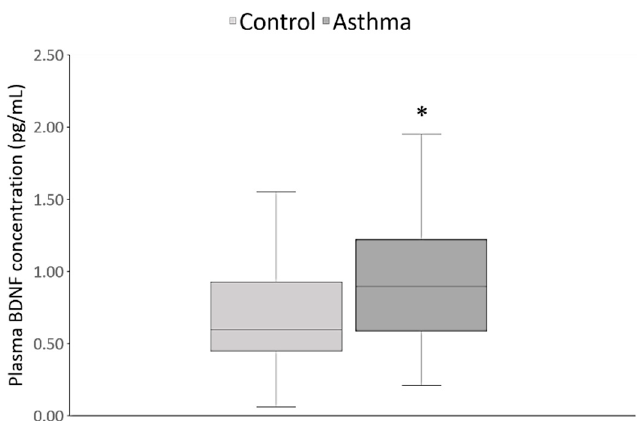
Figure 1. Plasma brain-derived neurotrophic factor (BDNF) concentrations were significantly higher in the asthma patients (0.89 pg / mL, 0.59–1.22) as compared to the healthy subjects (0.59 pg / mL, 0.45–0.92). * p < 0.0001, U = 4902.00, Mann-Whitney test.